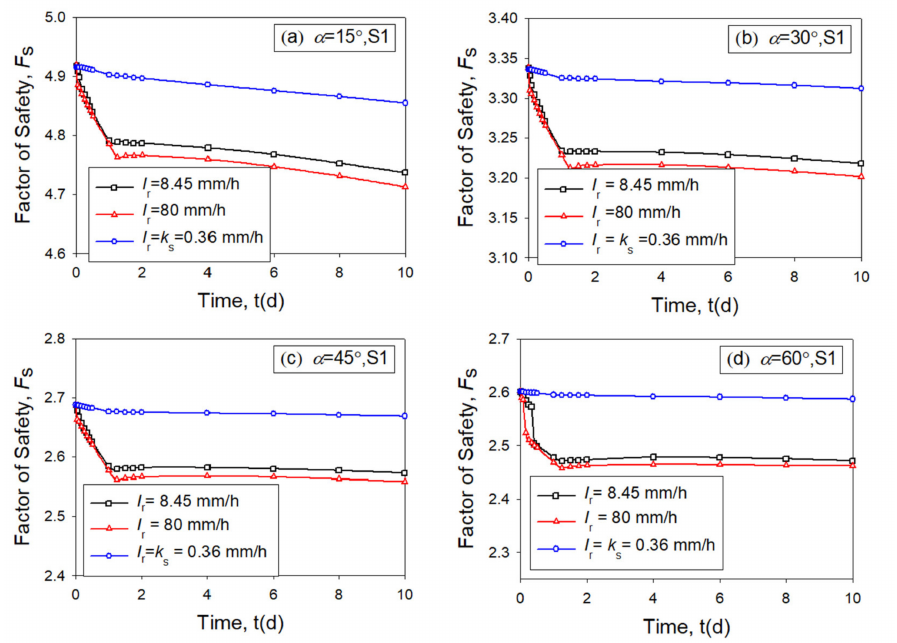
Figure 4. Variation diagram of F s of soil S1 for the slope with different slope angles, ( a ) α = 15 ◦ ; ( b ) α = 30 ◦ ; ( c ) α = 45 ◦ ; ( d ) α = 60 ◦